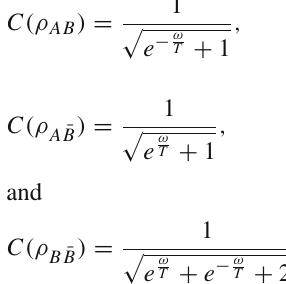
Fig. 3 The fermionic steerability and steering asymmetry between Bob and Anti-Bob as functions of the Hawking temperature T . The parameter ω is fixed as ω = 1 to zero again (sudden death) with the increasing of Hawk- ing temperature. The Hawking temperature for the maximal √ √ , and for sudden death steering is T max = ω ln ( 3 + 1 ) − ln ( 3 − 1 ) √ . This result is quite different from the is T dea = − ω ln ( 3 − 1 ) behavior of fermionic entanglement between Bob to Anti- Bob in a relativistic setting, where fermionic entanglement increases monotonically